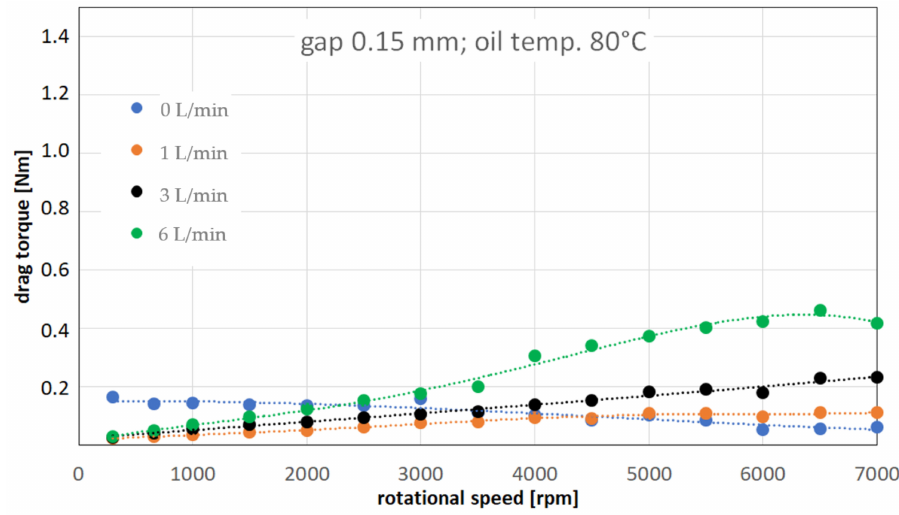
Figure 6. Drag torque characteristics for gap between plates 0.15 mm, oil temperature 80 ◦ C and various values of oil flow rate.